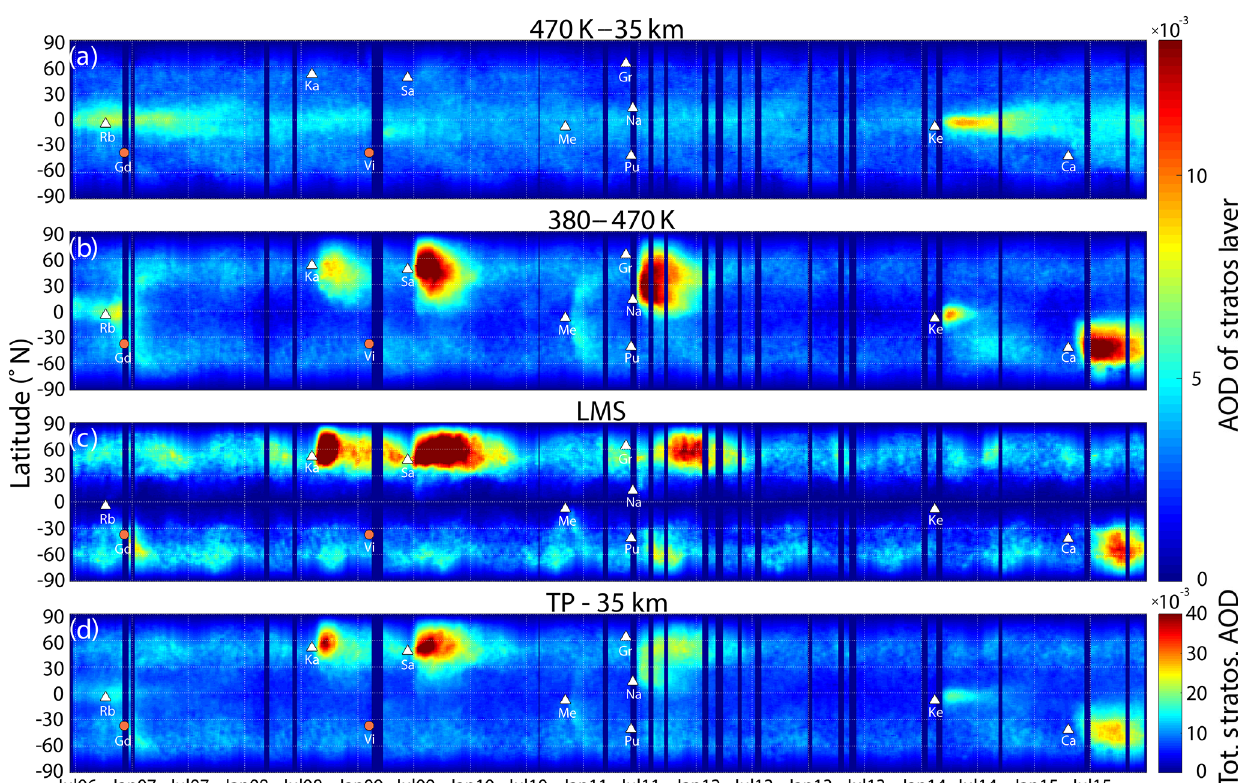
Figure 7. The latitudinal distribution over 10 years for the latitude-weighted stratospheric AOD: (a) above the 470K isentrope, (b) between the 380 and 470K isentropes, (c) the LMS, and (d) that of the entire stratosphere. The color bar for panels (a) – (c) spans a range of one-third that in panel (d) . Abbreviations and triangles (circles) mark time and latitude of relevant volcanic eruptions (forest